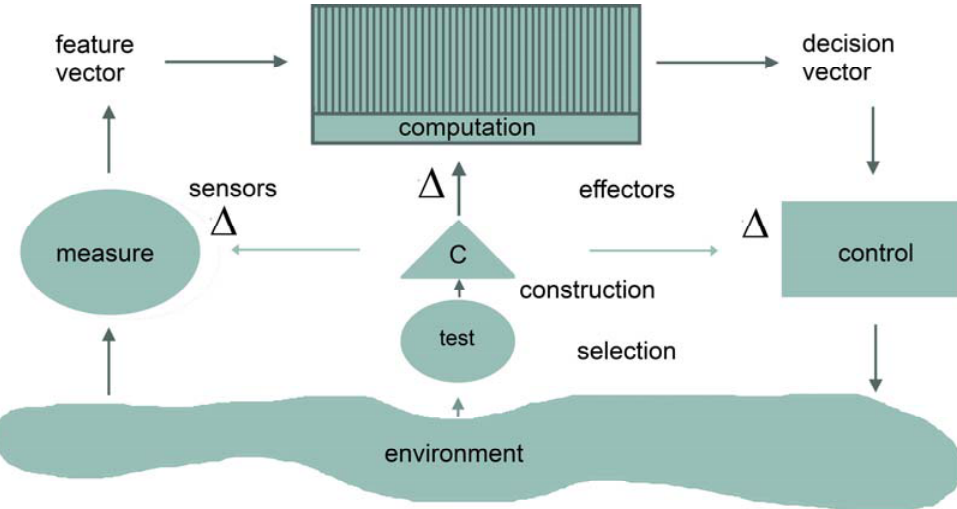
Figure 1. Schematic depiction of a structurally-adaptive device that can alter its sensors, effectors and computational part. The symbol Δ denotes the adaptation or change at one or more of the major moments of the system, and the letter C stands for construction (adapted from Cariani [26], with